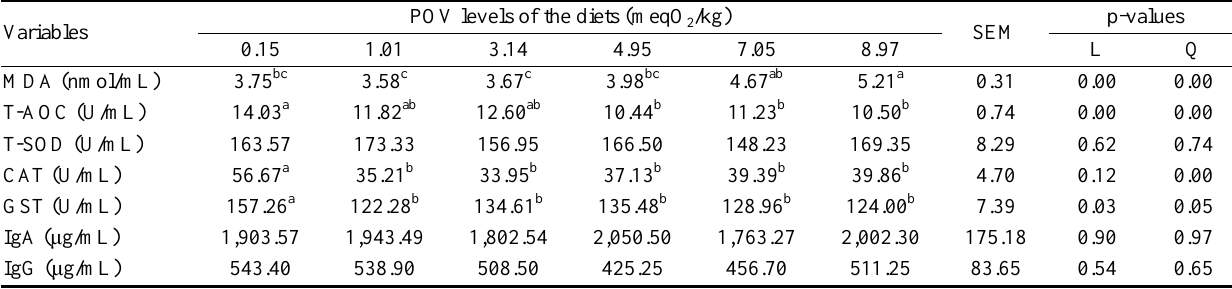
Table 4. Biochemical indices in plasma of broilers fed oxidized soybean oil